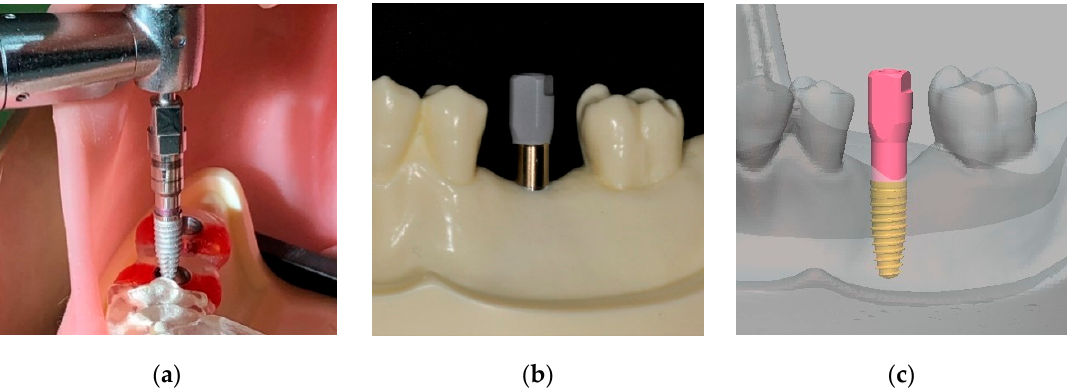
Figure 4. ( a ) Simulation implant placement performed on the model fixed to the manikin. ( b ) Scan body connected to the placed implant. ( c ) Implant position verified in the CAD